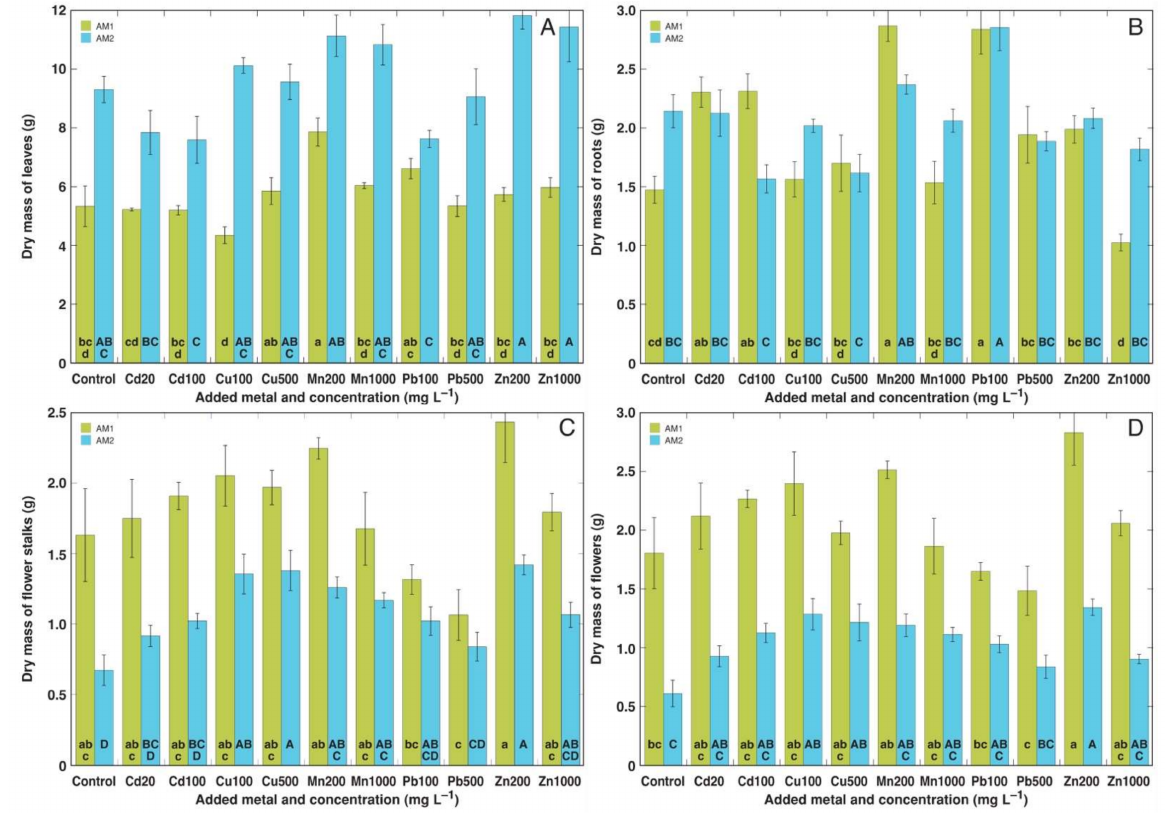
Figure 3. Effect of heavy metal treatment on dry mass of leaves ( A ), dry mass of roots ( B ), dry mass of flower stalks ( C ), and dry mass of flowers ( D ) of Armeria maritima accessions AM1 and AM2 cultivated for 9 weeks in soil. Cd20, Cd 20 mg L − 1 ; Cd100, Cd 100 mg L − 1 ; Cu100, Cu 100 mg L − 1